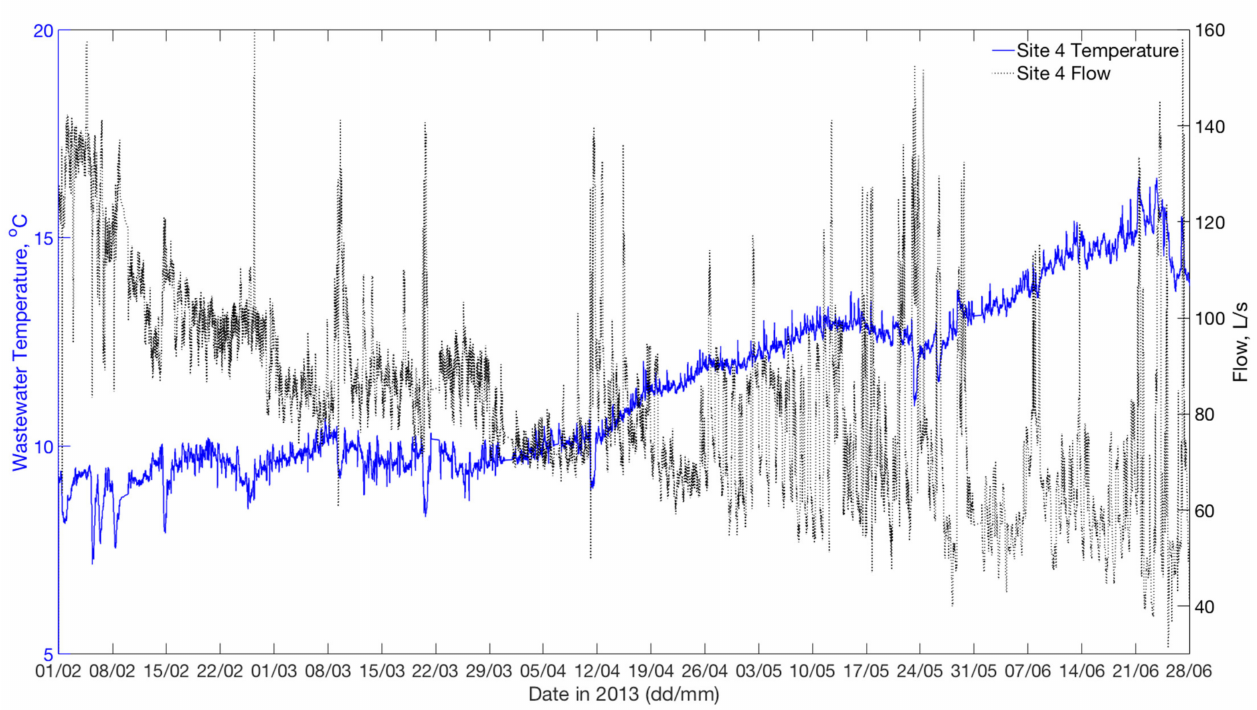
Figure 5. Observed wastewater temperatures and flow rates for site 4 (used for calibrating the collector sewer